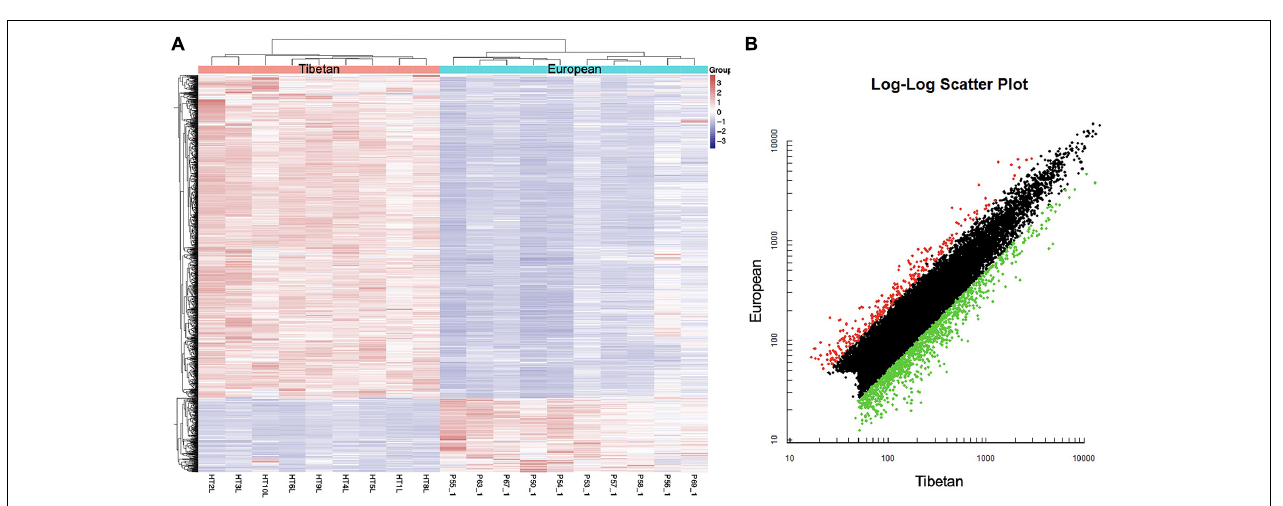
FIGURE 2 | Heat map (A) and scatter plot (B) of mRNA expression levels in Tibetan and European placenta samples. (A) Hierarchical clustering analysis of all covered human mRNAs. The Y -axis represents specific mRNAs and the X -axis represents individual samples, with the red on the top representing Tibetan and the blue representing European. The color frame represents the log2 intensities of the miRNAs; purple = low expression and red = high expression. (B) Green dot is the down regulated gene and red dot is the up regulated